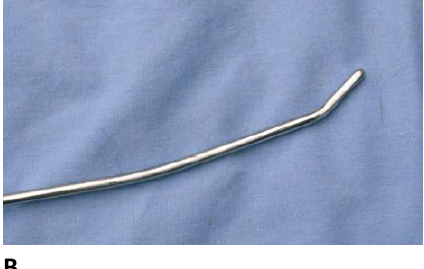
Figure 1: (A) The Nielson catheter that has been manually adapted to include a 30 degree distal bend at the tip and a 10 degree mid-shaft curve. (B) Shows a close up of the distal tip.